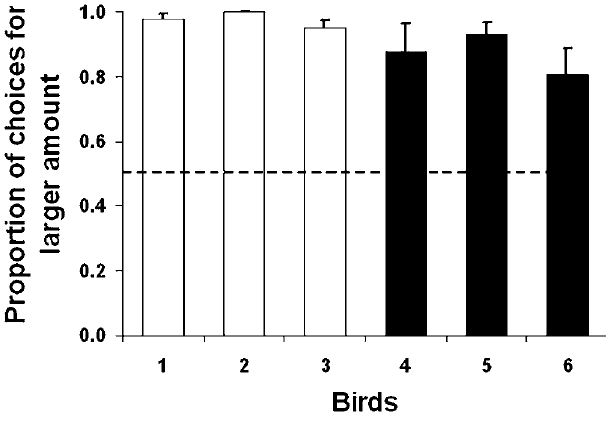
Figure 2. Discrimination Test Proportion of choices ( 6 standard error [s.e.]) made by birds for the option offering the largest amount of food when time parameters were held constant. Choice proportions are significantly different from random for all birds (binomial test, p , 0.01). Birds 1, 2, and 3 (white bars) were presented with choices between one and two units of food, and birds 4, 5, and 6 (black bars) with choices between two and five units of food. DOI: